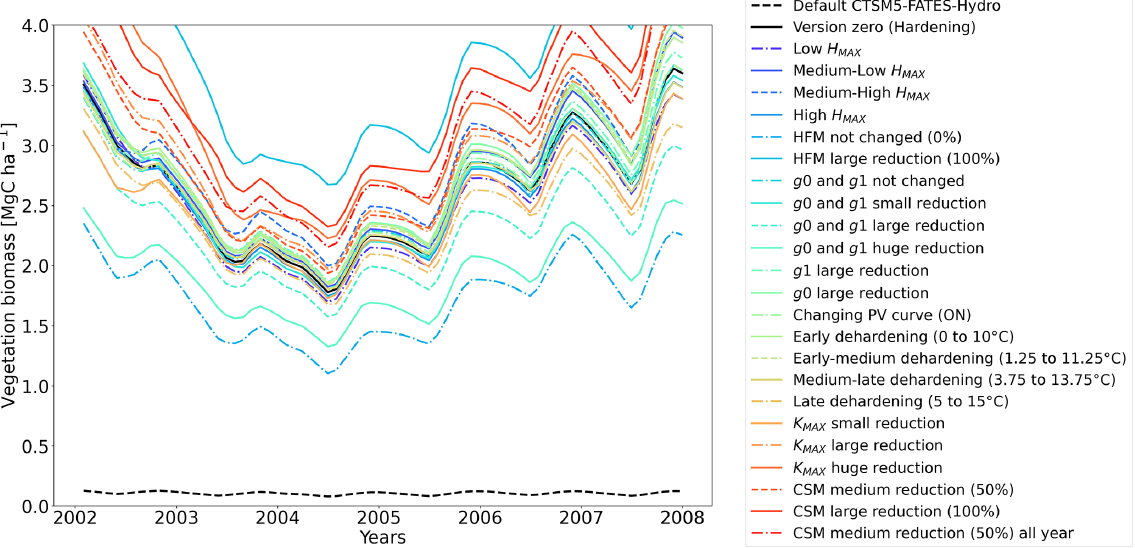
Figure 11. Ensemble of living biomass simulations for needleleaf evergreen trees at the site of Spasskaya Pad during the period 2002–2008.